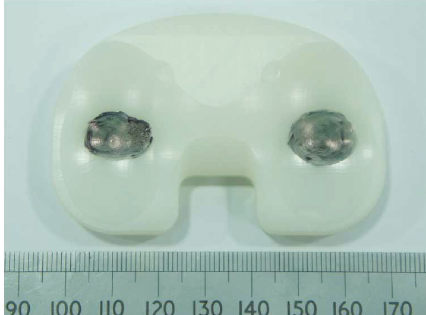
Figure 4: Experimental simulated volume removal test (the black area with the ink painting is the worn